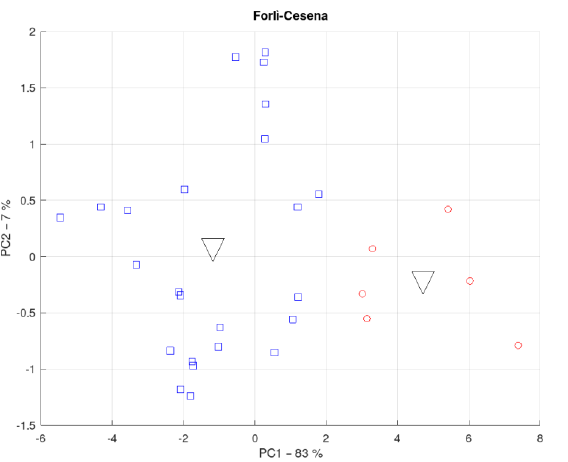
Figure 4. District of Forlì-Cesena 2D-Score plot showing PC1 vs. PC2 with clusters highlighted: first cluster in red and the second cluster in blue. cluster in red and the second cluster in